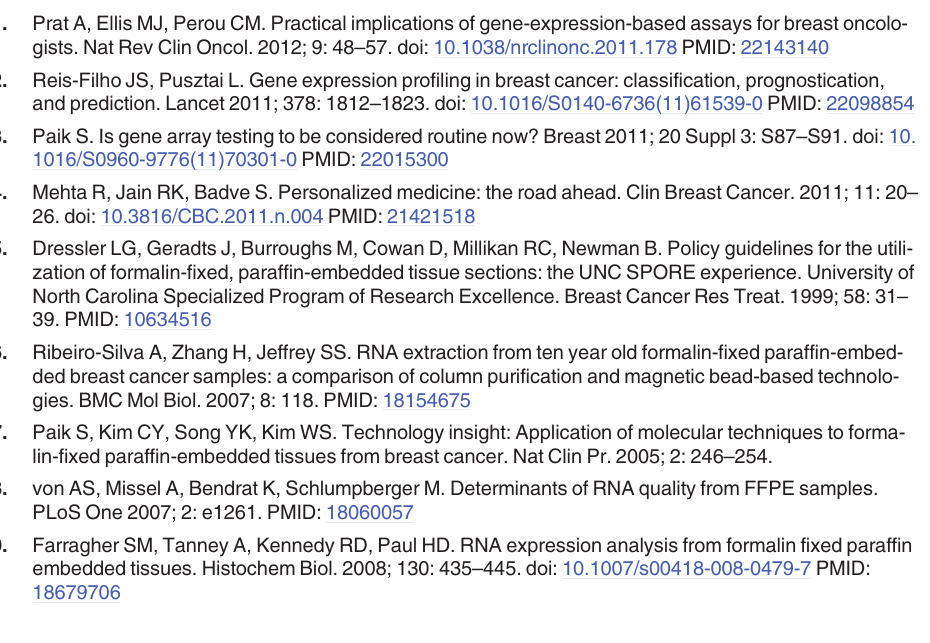
S1 Fig. Outline of the study experimental design and set of samples used. (TIF) S2 Fig. Correlation between Ct values and present calls. RPLC13a qPCR threshold values (determined on the cDNA fraction prior to linear amplification) as a function of present calls later obtained on Affymetrix HG-U133 2.0 Plus chips for 44 FFPE breast cancer samples from our pilot study. S3 Fig. Quality control on raw data for GEPs derived from 46 FFPE breast cancer samples. GEPs from the pilot study using Affymetrix HG-U133 2.0 Plus chips are reported. A. Box plot of raw data intensities. B. Heat map reporting the reciprocal correlations (Pearson correlation